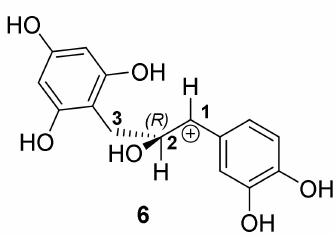
Figure 4. Most stable conformation of the benzylic carbocation intermediate ( 6 ) with the α -H in the 1,3-allylic strain